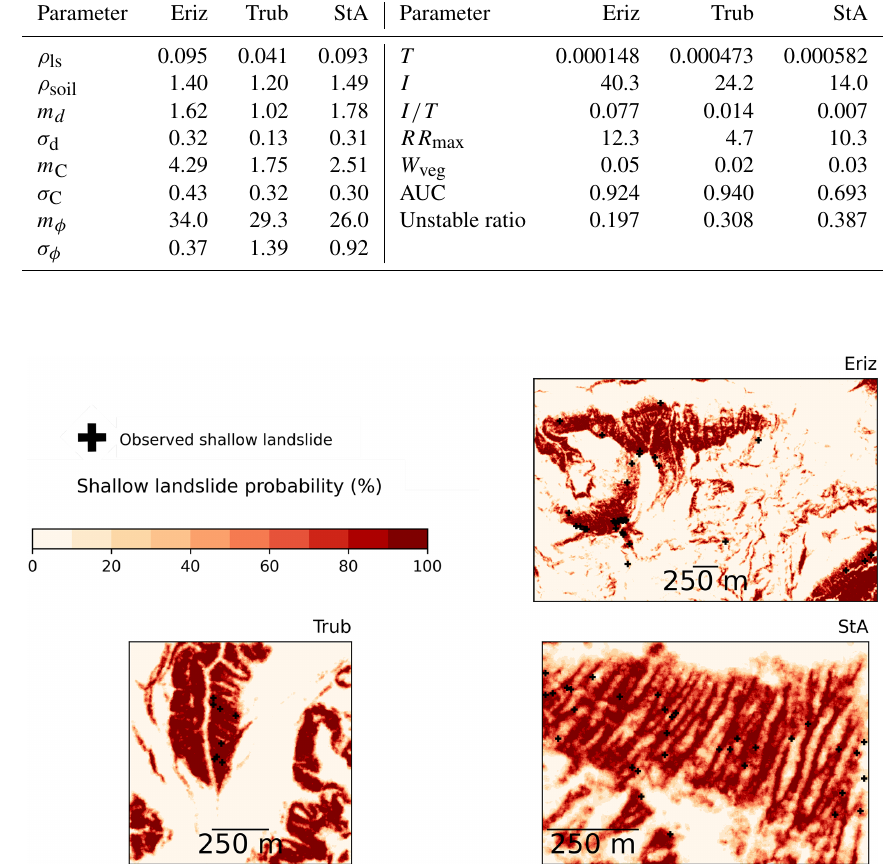
Table 7. Outcome of the Monte Carlo-based calibration: the parameter sets per study area resulting in the highest AUC value. The last row shows the ratio of unstable HLs resulting from these parameter sets.